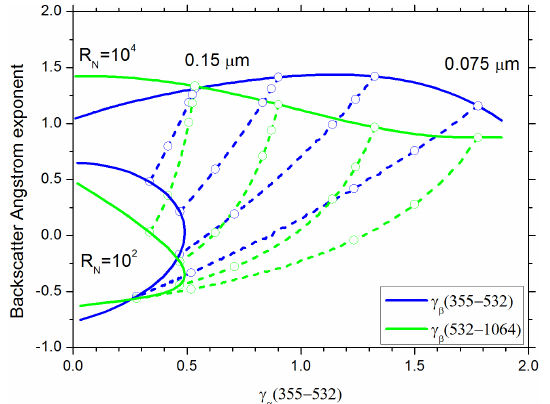
Figure 19. Backscatter Ångström exponents γ β (355–532) and γ β (532–1064) vs. γ α (355–532). Solid lines show results for fixed = 10 2 , 10 4 , while r ratios R N = N f f varies from 0.07 to 0.2µm. N c Dash lines correspond to R N varied in the range 10 2 –10 4 for cho- sen values r f = 0 . 075, 0.1, 0.125 and 0.15µm; open symbols mark results for R N = 10 2 , 5 × 10 2 , 10 3 , 5 × 10 3 and 10 4 . The complex refractive index used in computations is m = 1.45– i